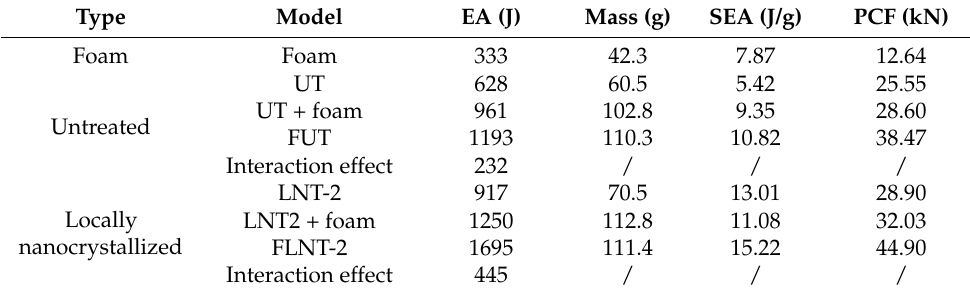
Table 4. Effects of foam on energy absorption for thin-walled tubes.